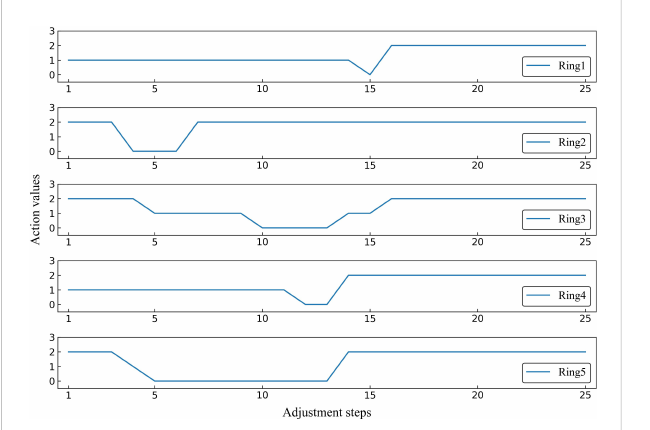
FIGURE 6 The obtained plan score of one representative case in the MOAPN adjustment steps.